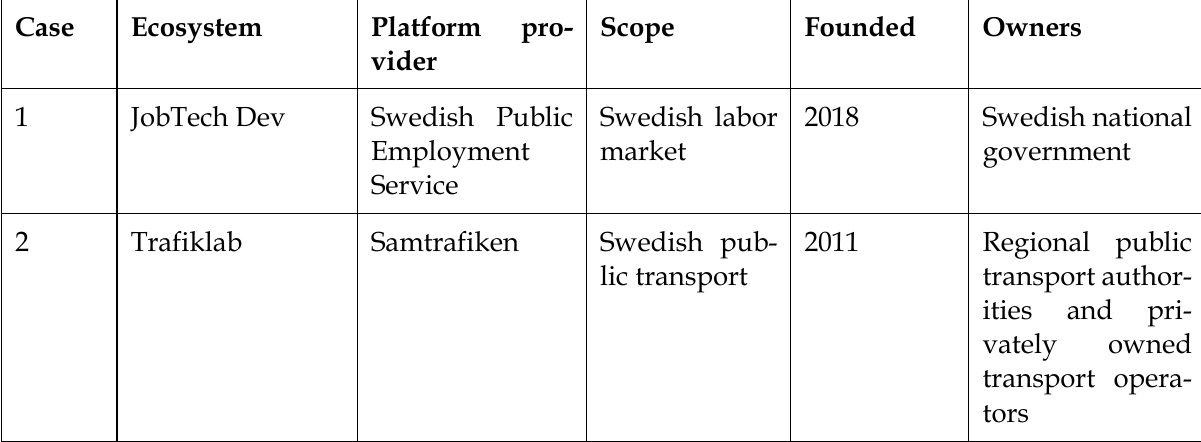
Table 1: Characteristics of the four OGD ecosystems studied.